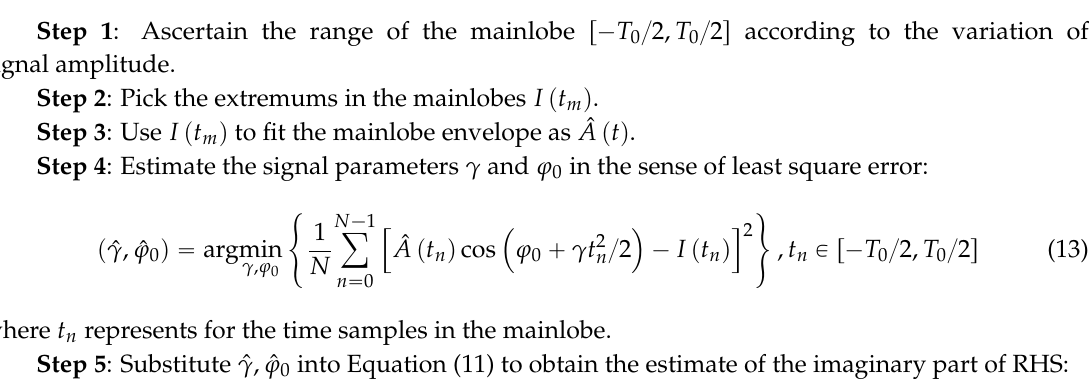
Figure 9. Flowchart for the reconstruction of RHS in mainlobe.